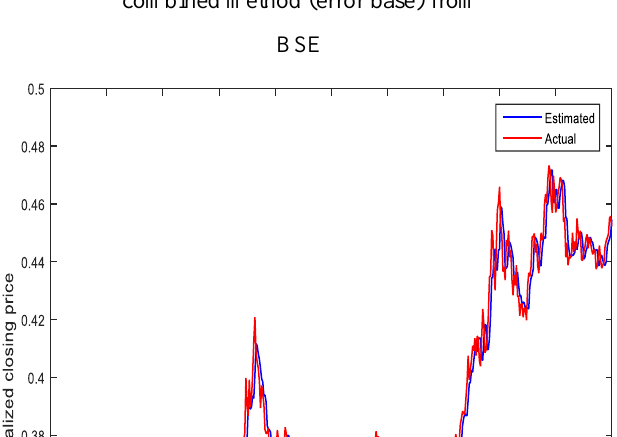
Figure 9 . Actual v/s estimated closing prices by combined method (error base) from